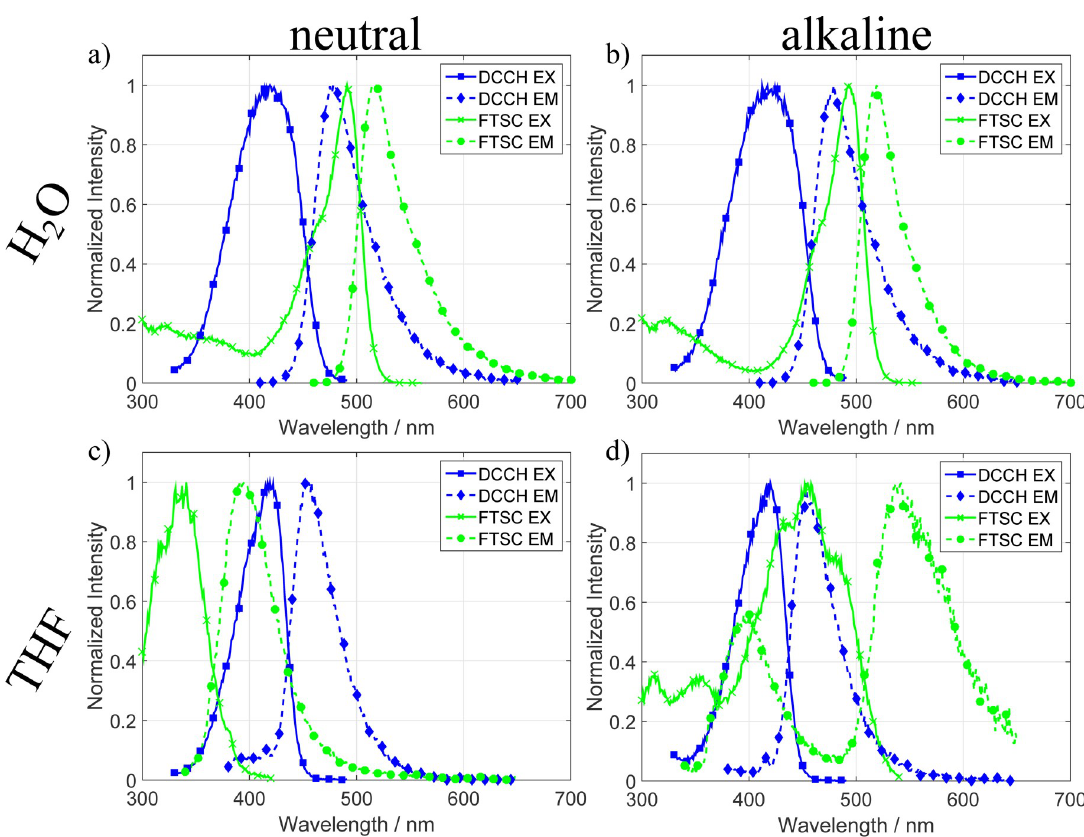
Fig 3. Normalized excitation and emission spectra of DCCH and FTSC in different solvents and pH values. In a) and b) one can see the spectra in water under neutral and alkaline conditions. One important feature in c) and d) is that in the neutral solution the FTSC spectra shift strongly (130–150 nm) into the blue compared to the H 2 O spectra. In the alkaline solution the spectra shift back to the red and exhibit many side